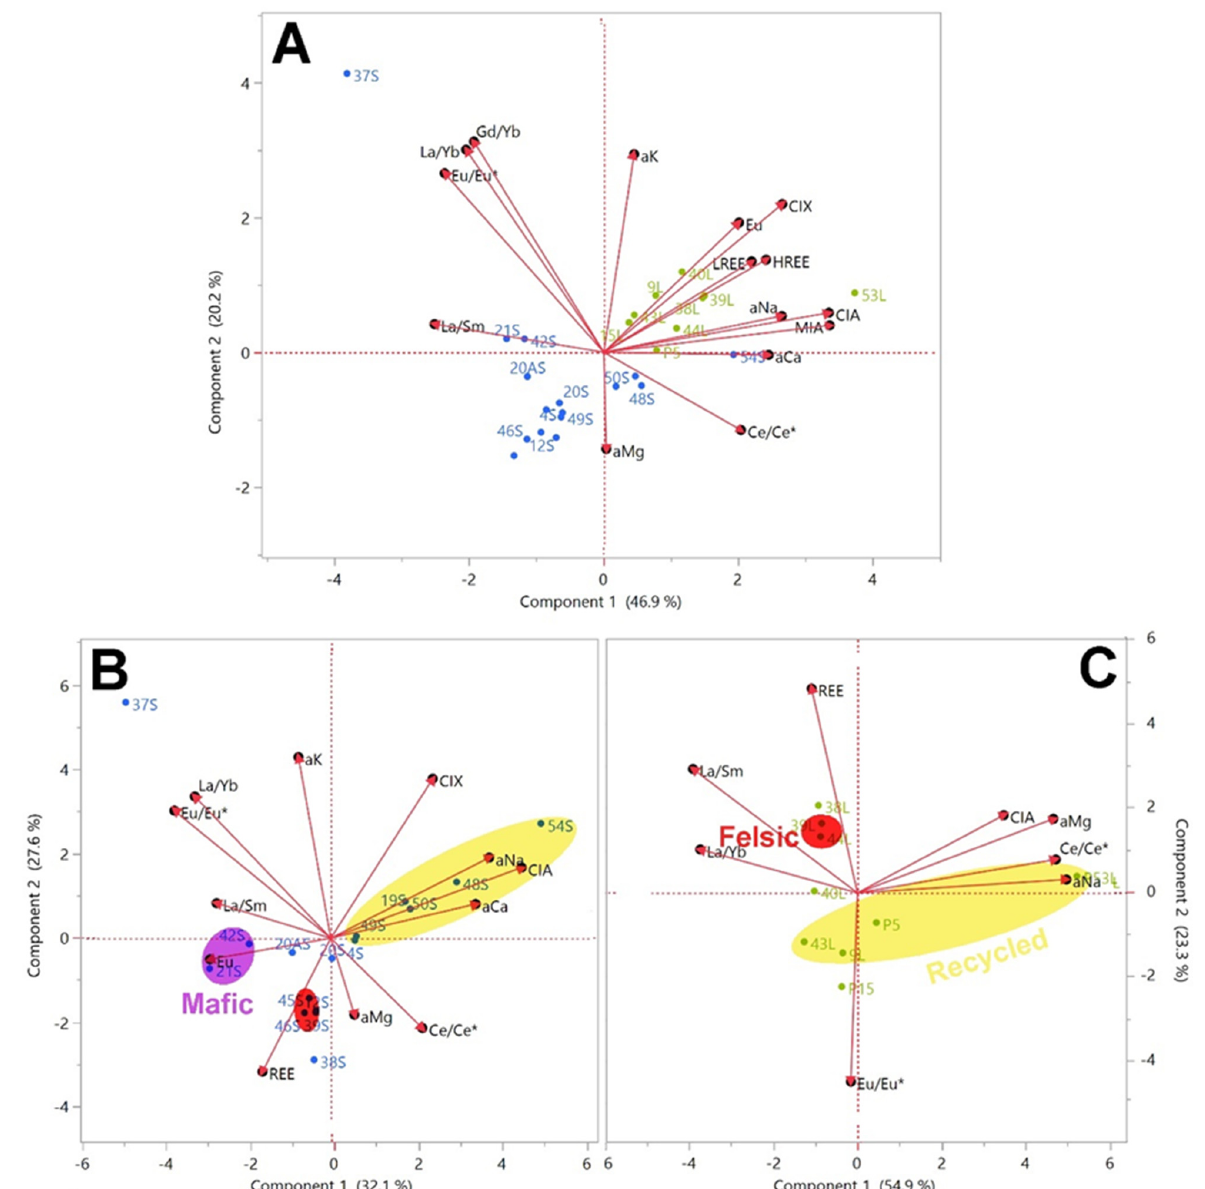
Figure 8. PCA map performed to assess the effect of weathering on REE geochemistry. Results for the entire dataset ( A ), sand deposits ( B ), and mud deposits ( C ) are presented. “a” stands for α . See further explanation of weathering proxies and REE parameters in the text.